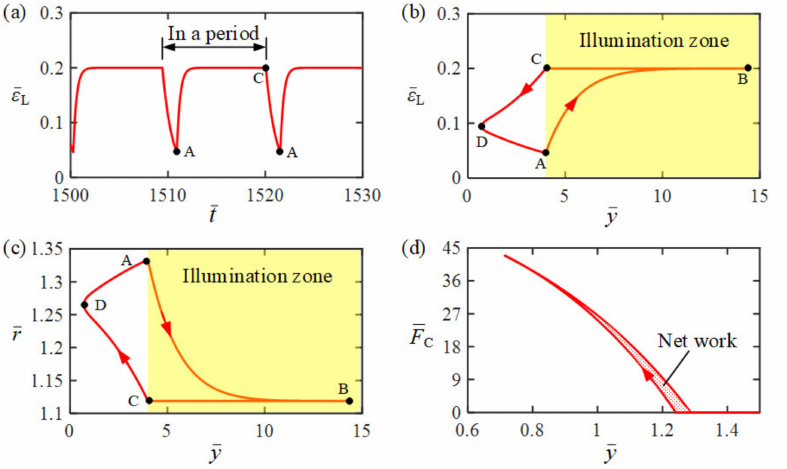
Figure 3. Mechanism of the self-jumping LCE balloon, for I 0 = 2, C 0 = 0.3, H = 4, β = 0.01, E = 500, . = 0.5, g = 1, y = 30, and = 0. ( a ) The time history of light-driven contraction n g = 200, p y am 0 0 of the LCE balloon. ( b ) The dependence of light-driven contraction on the position of the balloon in one cycle of self-jumping. ( c ) The dependence of radius on the position of the balloon in one cycle of self-jumping. ( d ) The dependence of contact force on position. The dependence of both light-driven contraction and radius on position forms a cycle along the path of A → B → C → D → A. The area enclosed by the loop in Figure 3d represents the net work done by contact force, which compensates the damping dissipation and maintains the